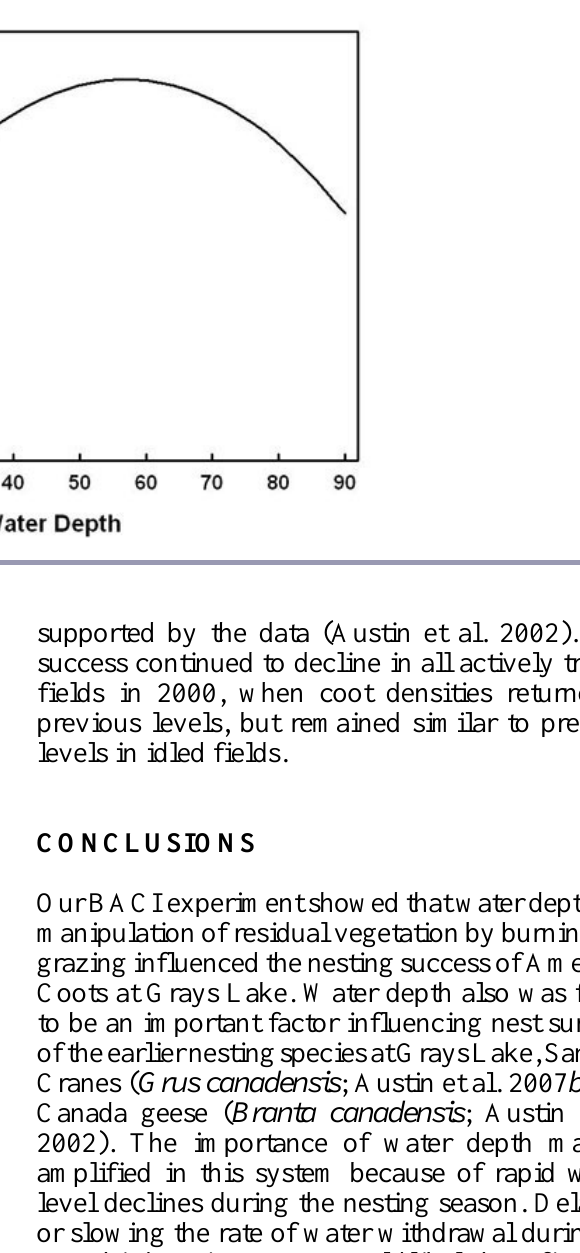
Fig. 4. Nest success rate by water depth, averaged across all year by treatment combination, for nests initiated at median initiation date of 27 May, for American Coot ( Fulica Americana ) nests at Grays Lake, Idaho during 1997–2000. Nest success rate was a model estimate based on a 27-day exposure